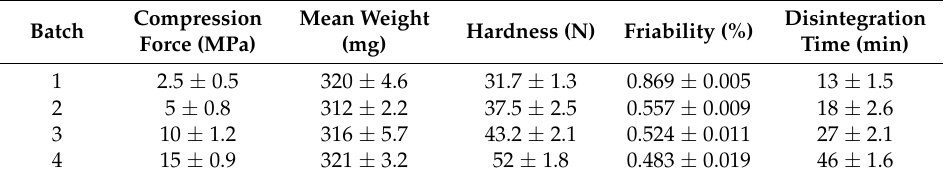
Table 1. Technological characterization of tablets, n = 6.